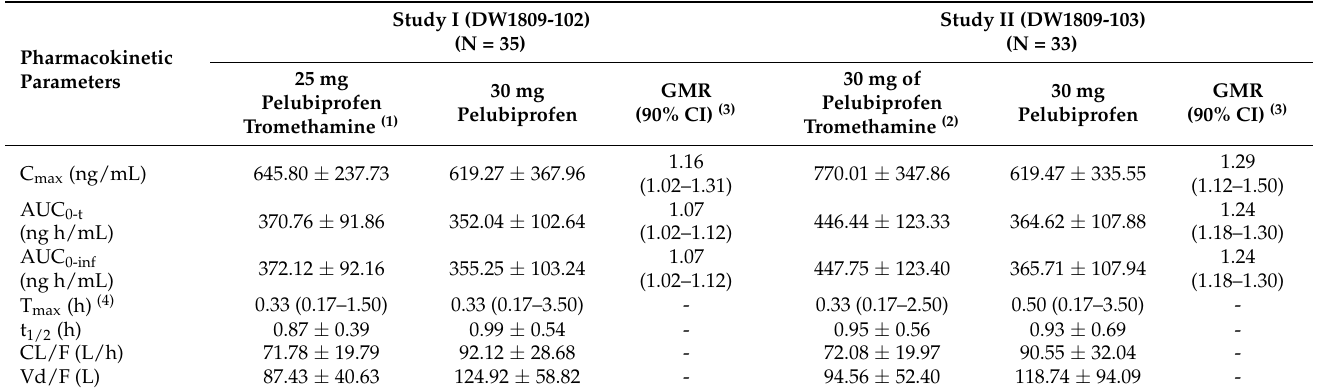
Table 3. The pharmacokinetic parameters of different formulations of